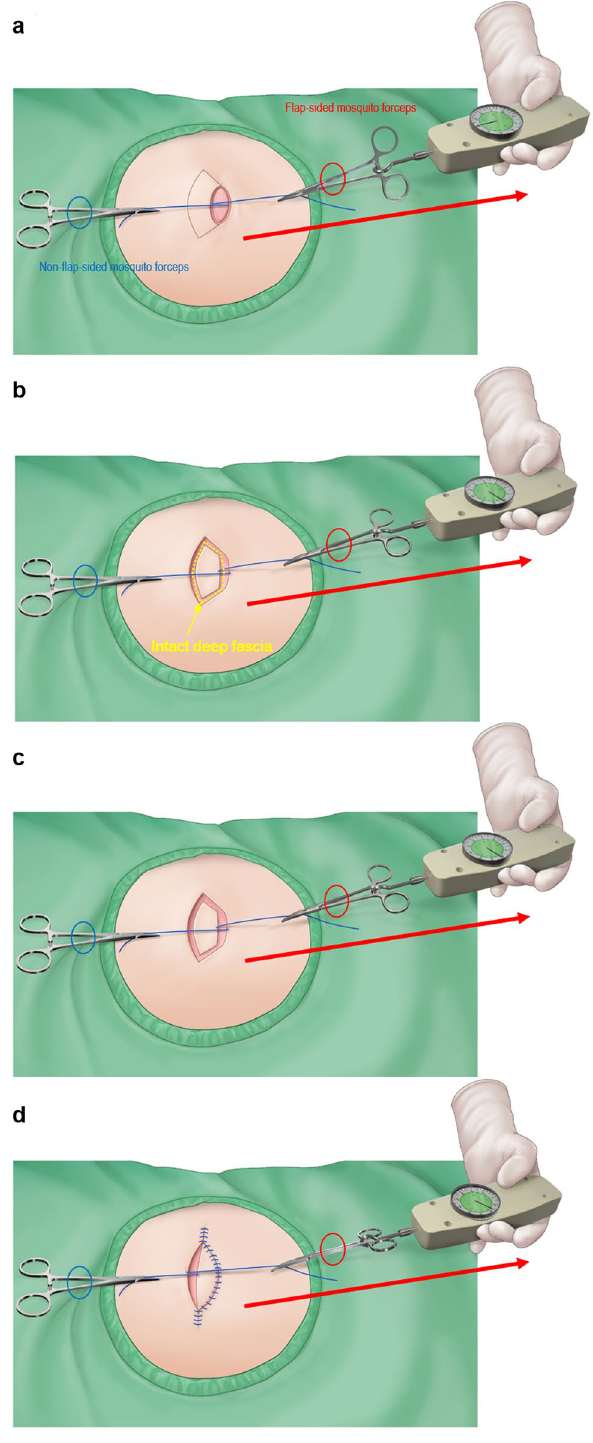
Figure 1. Schematic illustration of the procedure for intraoperative tensiometer measurement. A surgeon passes 3–0 nylon sutures through both wound edges at the most concave point and attaches mosquito forceps to each suture. The surgeon then connects the tensiometer to the flap-sided forceps and gently pulls it toward the non-flap-sided forceps until the two wound edges are as approximate as possible. At this time, the non-flap-sided forceps are not pulled but are kept in place as the reference point for the direction of the flap-sided forceps. The surgeon performed three consecutive measurements for each parameter in this way and calculated the average value. In all these procedures, the tensiometer should be sterilized for intraoperative use. The red-colored oval represents the flap-sided mosquito forceps, and the blue oval represents the non-flap-sided mosquito forceps. ( a ) Measurement of “pre-flap tension at the defect.” ( b ) Measurement of “Type I keystone perforator island flap (KPIF) tension at the defect.” The yellow dotted line represents the intact deep fascia before division. ( c ) Measurement of “Type II KPIF tension at the defect.” ( d ) Measurement of “post-flap tension at the donor.” (Figures ( a ), ( c ), and ( d ) were reprinted from Yoon et al. 8 , with permission from Springer